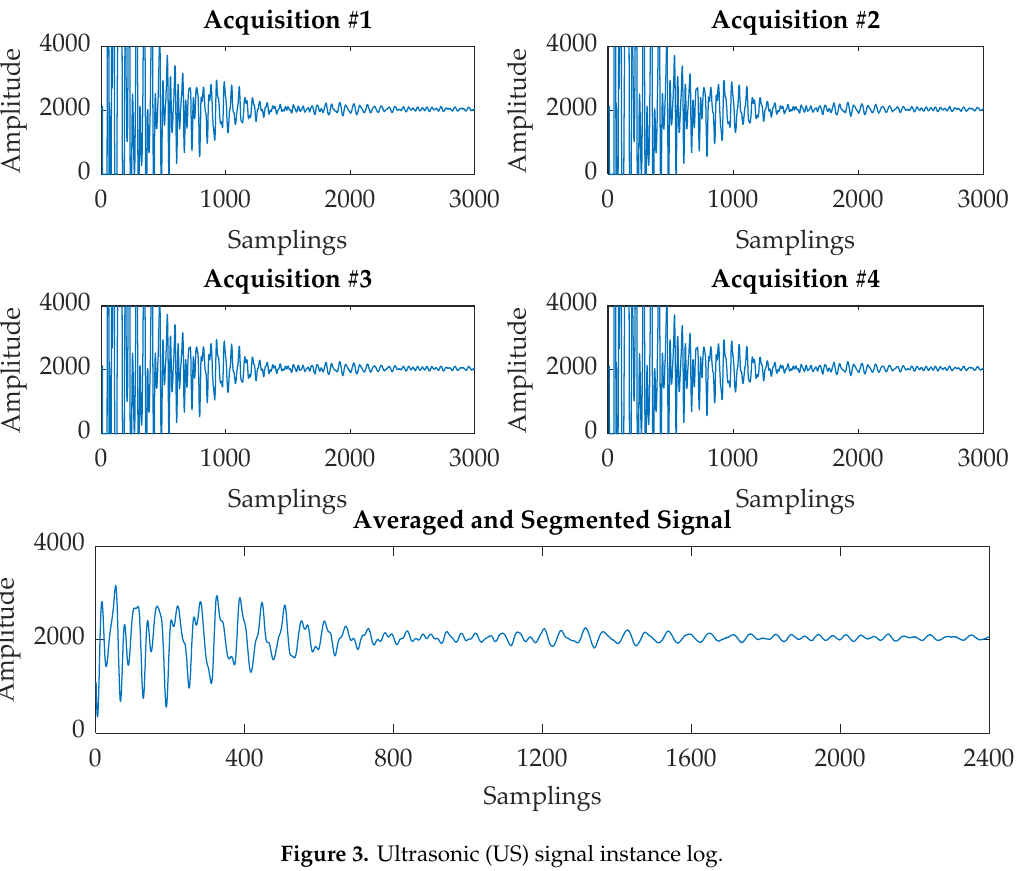
Figure 3. Ultrasonic (US) signal instance log.